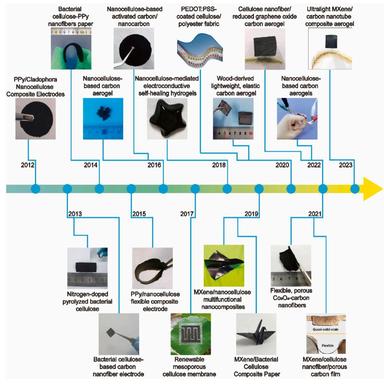
Concise timeline of nanocellulose-based composites for advanced supercapacitor electrodes. Paper-based energy-storage devices comprising carbon fiberreinforced polypyrrole-cladophora nanocellulose composite electrodes. Fabrication of a flexible all-solid-state high-power supercapacitor using nitrogen-doped carbon nanofiber electrode material derived from bacterial cellulose. Electrode materials based on bacterial-cellulose-derived carbon nanofiber@MnO2 and nitrogen-doped carbon nanofiber. Optical images of